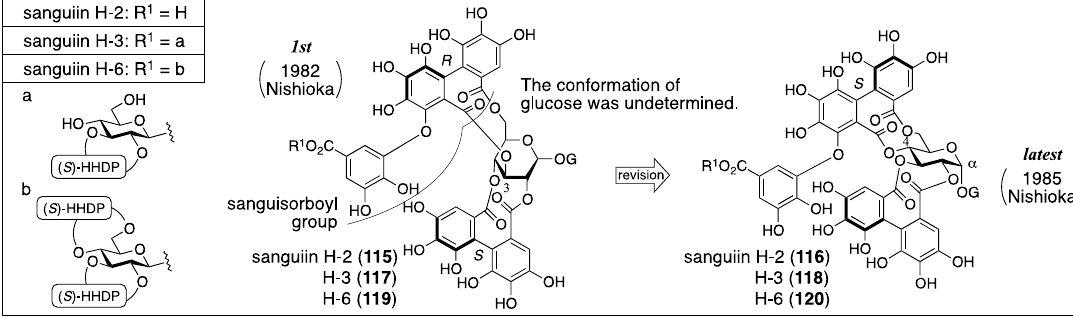
Figure 43. The transition of the structure of sanguiin H-2, H-3, and H-6. The conformation of the glucose moiety in the first structures was undetermined.